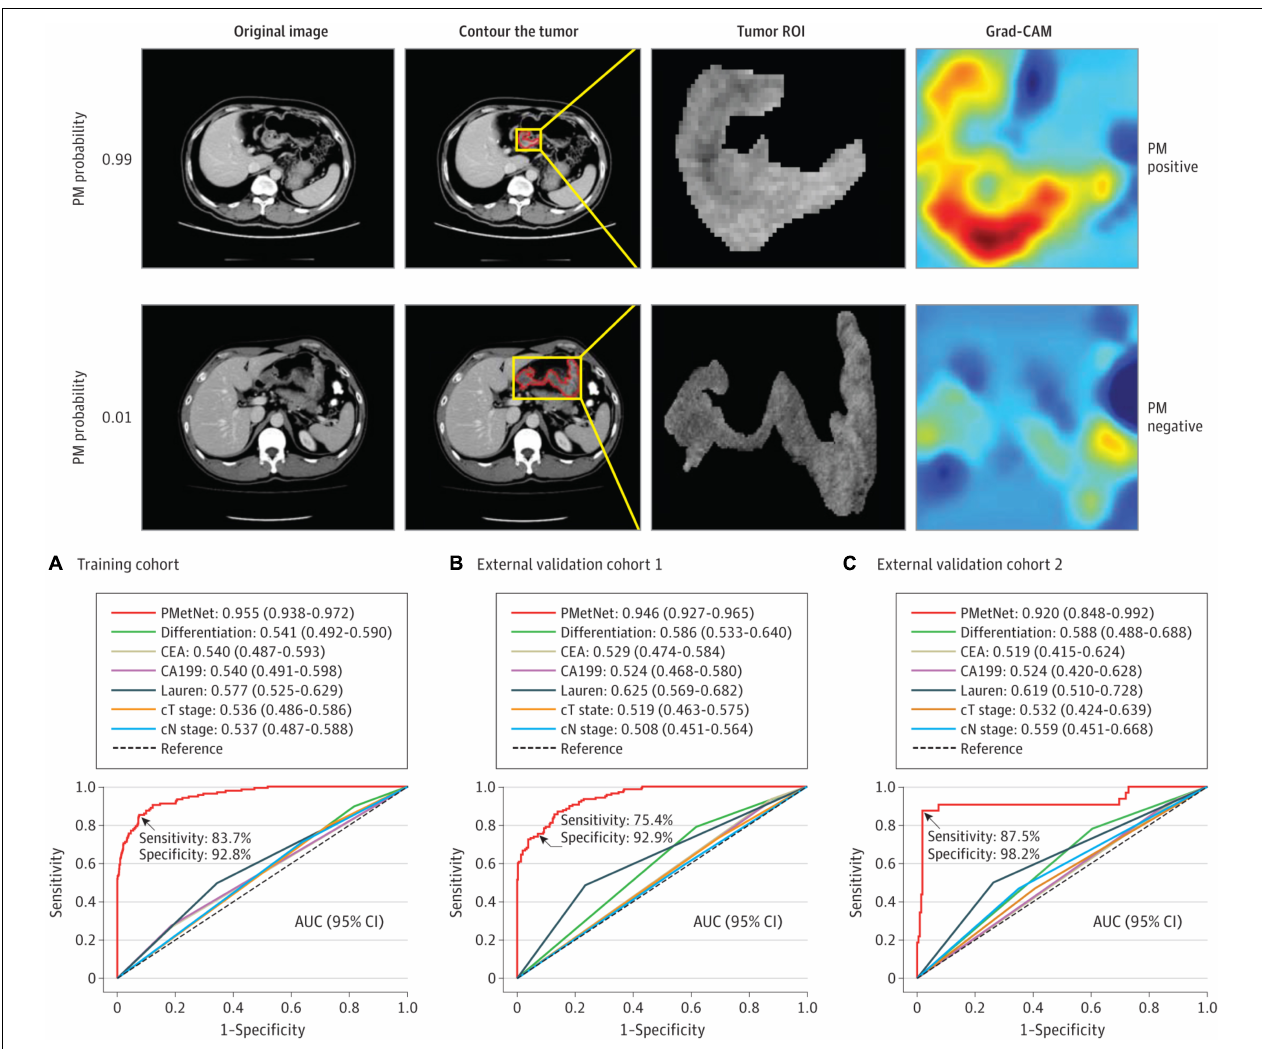
FIGURE 2 | Evaluation of a CNN-based DL algorithm (PMetNet) for detection of occult peritoneal metastases (PM) from gastric cancer on preoperative CT images. (Upper) Following tumor segmentation on original CT images (tumor contours highlighted in red, tumor region of interest [ROI] shown within magnified tumor location [boxed in yellow]), the gradient-weighted class activation mapping (Grad-CAM) was used to highlight which areas of the CT image are important in generating a particular prediction. The numbers 0.99 and 0.01 represent the predicted probability of PM. (Lower) Area under the receiver operating characteristic curves (AUCs) derived from the PMetNet and clinicopathological factors for the diagnosis of occult PM in the training cohort and in two validation cohort. The discrimination performance of PMetNet was substantially higher than conventional clinicopathological factors, and in multivariable logistic regression analysis, PMetNet was an independent predictor of occult PM. Adapted from Jiang et al. (2021) under Creative Commons Attribution 4.0 (CC BY 4.0) license (https://creativecommons.org/licenses/by/4.0/).